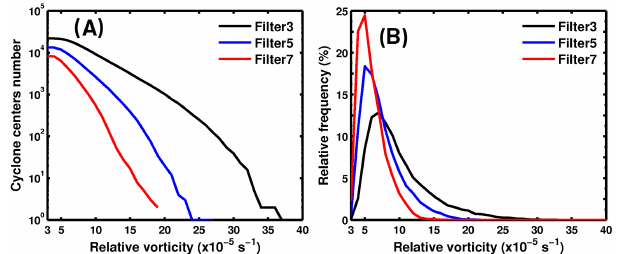
Figure 6. (a) The number of cyclonic centers as function of their relative vorticity and as detected by the three algorithm sensitivity tests. (b) Relative frequency distributions as a function of the rela- tive vorticity for the identified cyclone centers.